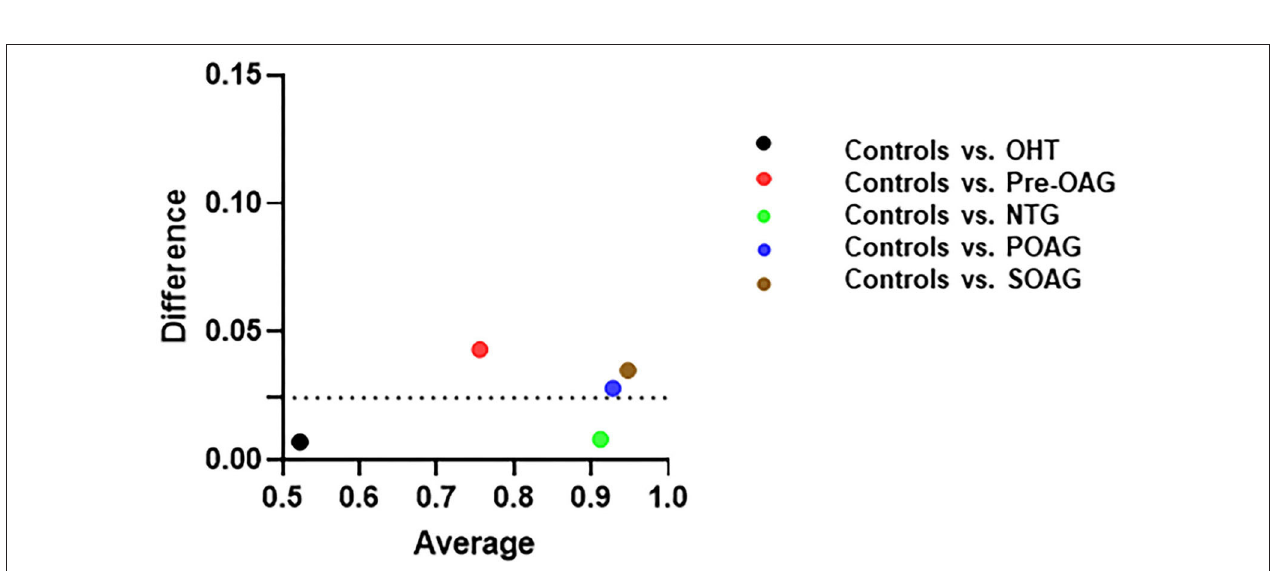
FIGURE 3 | Differences between AUC of quantitative GV (global value) and qualitative. QTV (qualitative total value) plotted against their corresponding average (sum of GV and QTV for each subgroup) in OHT, pre-OAG, NTG, POAG, SOAG vs. controls.